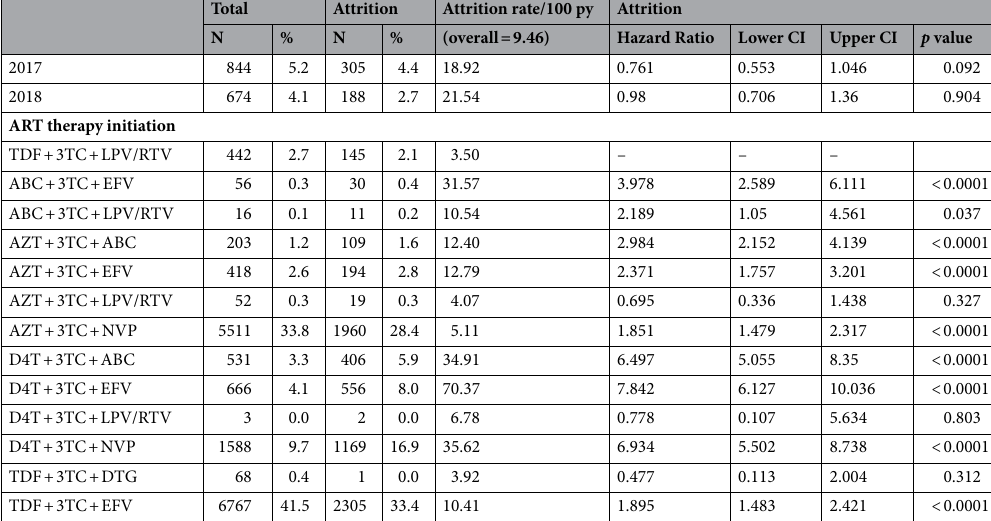
Table 4. Cox proportional hazards model for attrition among PLWH on ART at Carmelo Hospital of Chókwè (2002–2019). 1 p -values based on Cox regression proportional hazard risk. ART antiretroviral treatment, ABC